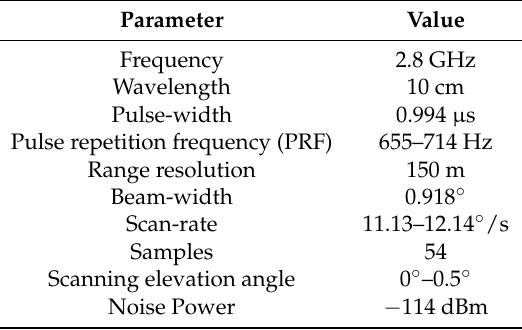
Figure 2. Radar backscattered power: ( a ) 0 ◦ elevation angle; ( b ) 0.5 ◦ elevation angle. Table 1. Technical specifications of the S-Pol Radar and operational parameters used in the